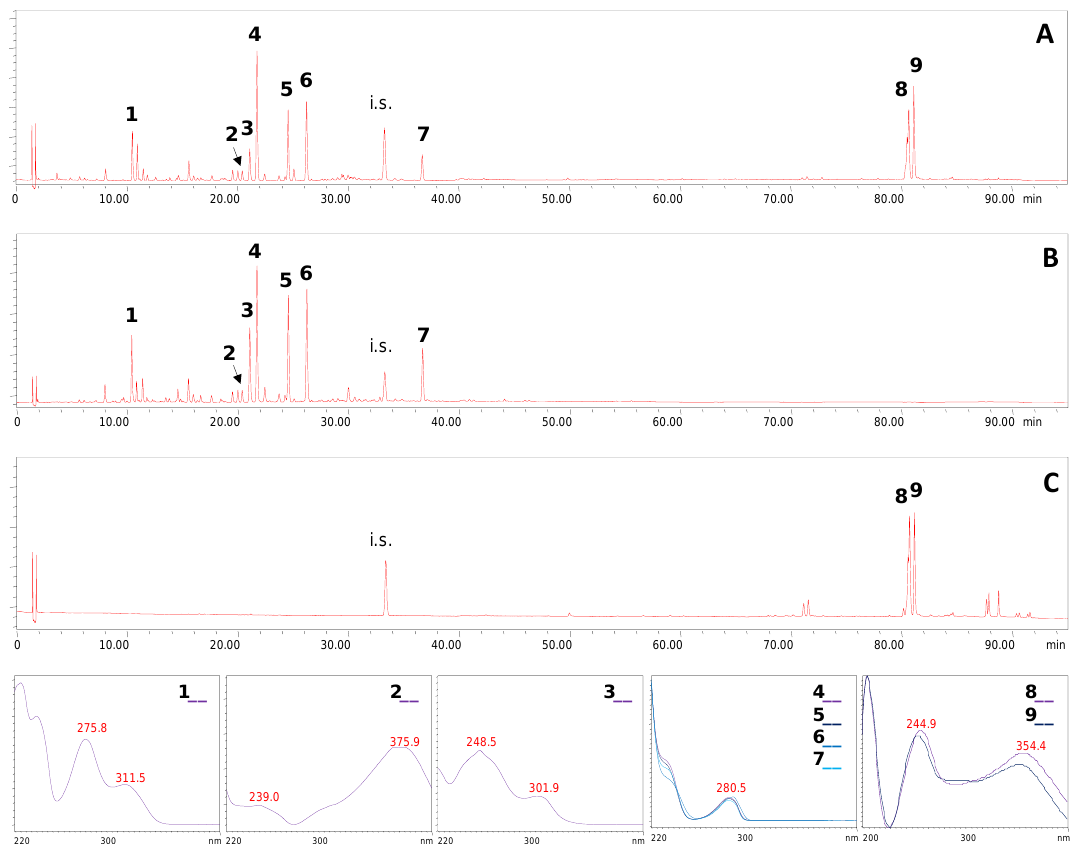
Figure 2. HPLC chromatographic profiles (275 nm) of Brazilian red propolis ( A ) in comparison with the resins of Dalbergia ecastaphyllum ( B ) and Symphonia globulifera ( C ). Numbers correspond to liquiritigenin ( 1 ), isoliquiritigenin ( 2 ), formononetin ( 3 ), vestitol ( 4 ), neovestitol ( 5 ), medicarpin ( 6 ), 7- O -neovestitol ( 7 ), guttiferone E ( 8 ), and oblongifolin B ( 9 ). UV spectra of compounds 1 – 9 are displayed at the bottom of the figure.